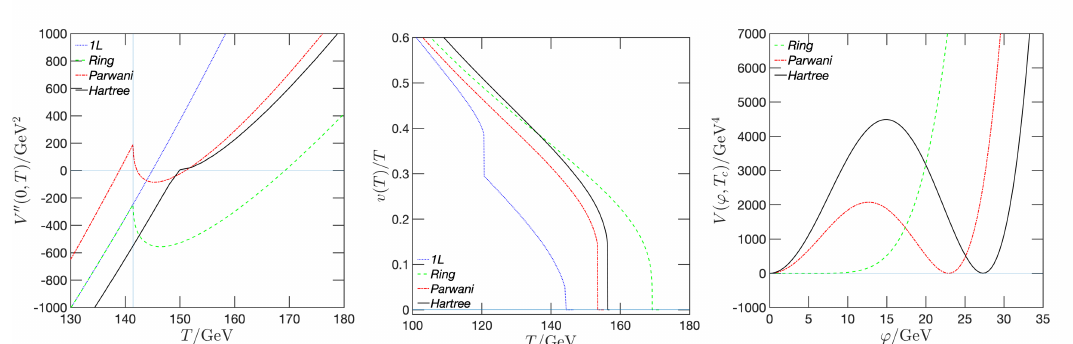
Figure 3 . Left: the evolution of the second ϕ -derivatives of the different potentials at ϕ R = 0 . Middle: the evolution of the ratio v ( T ) /T , where v ( T ) is the position of the second minimum. Right: the potential at critical temperature in each approximation. The critical temperatures are T c ≈ 169 . 20 GeV in the ring, T c ≈ 153 . 29 GeV in the Parwani and T c ≈ 155 . 67 GeV in the Hartree approximation. We used m R = 100 GeV and λ R = 6 (which implies λ (4) ’ 5 . 2 ). The vertical line R p in the left panel shows T 0 = 12 /λ R m R , where the high-temperature limit approximated thermal mass vanishes at ϕ R = 0